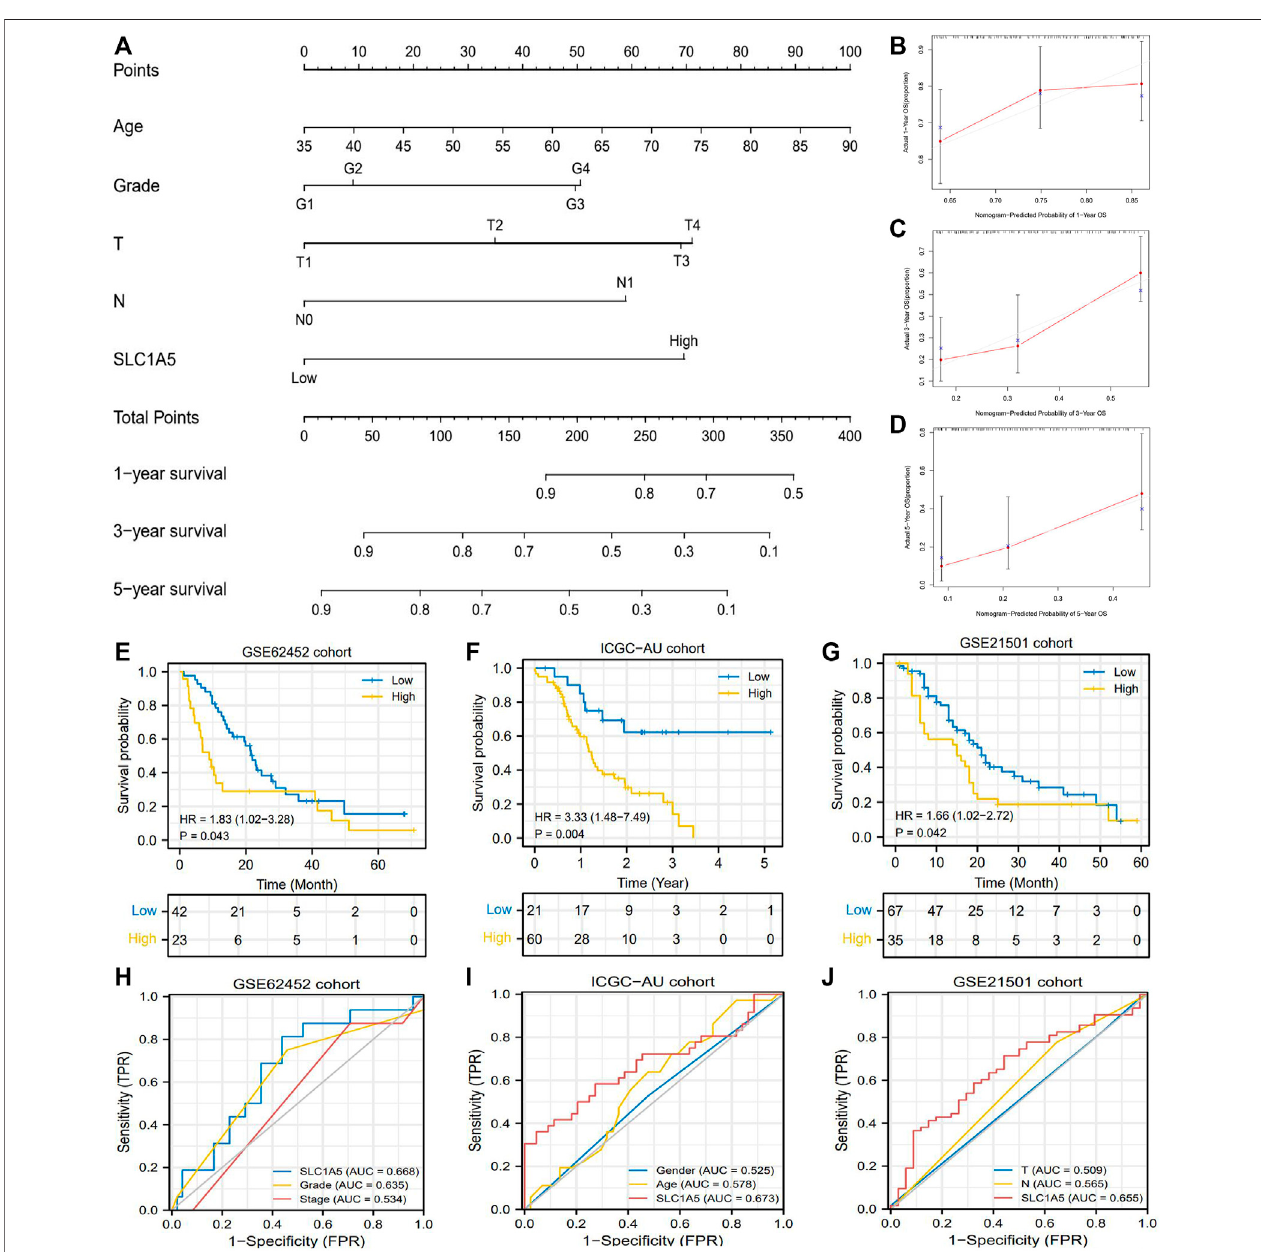
FIGURE4| TheprognosticvalueofSLC1A5isvalidatedinmultiplecohorts. (A) Thenomogrampredictingthe1-,3-,and5-yearoverallsurvivalprobabilityofPAAD patients. (B – D) Calibration curve of the nomogram. (E) OS difference between high- and low-SLC1A5-expression groups in the GSE62452 cohort. (F) OS difference in the ICGC-AU cohort. (G) OS difference in the GSE21501 cohort. (H) ROCs of the GSE62452 cohort. (I) ROCs of the ICGC-AU cohort. (J) ROCs of the GSE21501 cohort. PAAD, pancreatic adenocarcinoma; OS, overall survival; ROC, receiver operating characteristic curve; FPR, false positive rate.